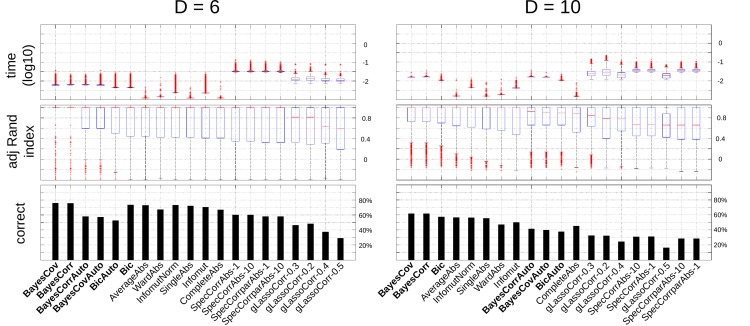
Simulation study.Computational time (top), adjusted Rand index (middle) and proportion of correct classifications (bottom) for D = 6 (left) and D = 10 (right).